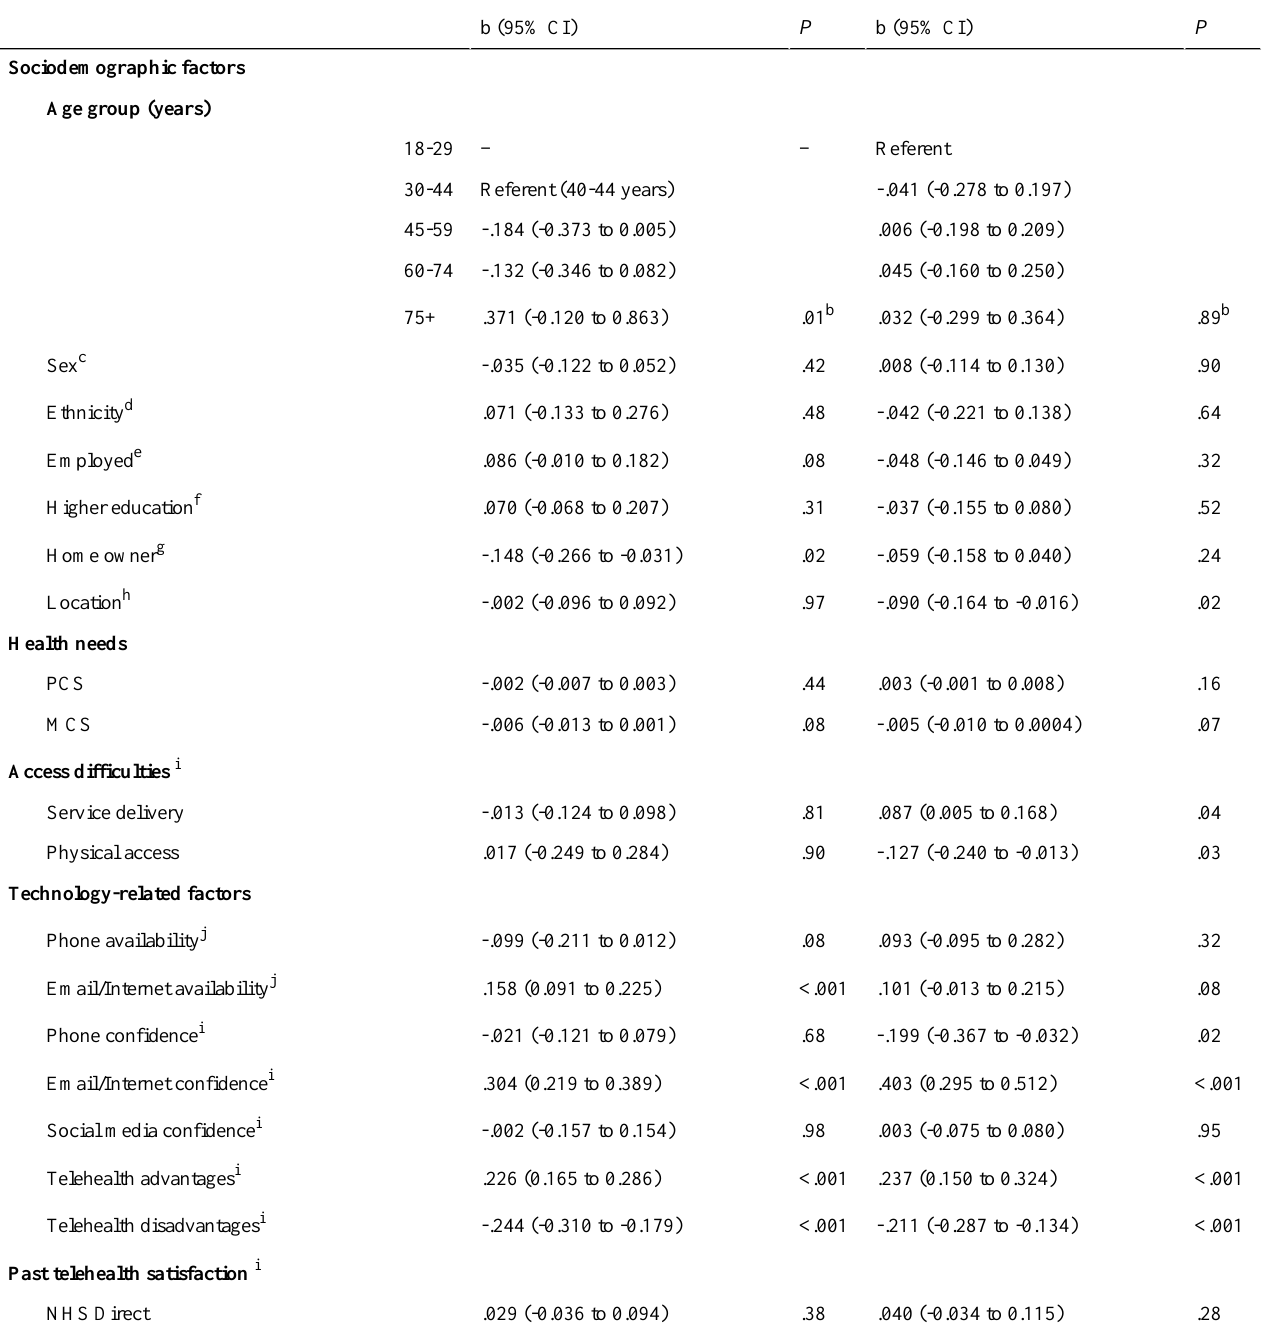
Table 5. Multivariable analysis of factors associated with interest in email/Internet-based telehealth a